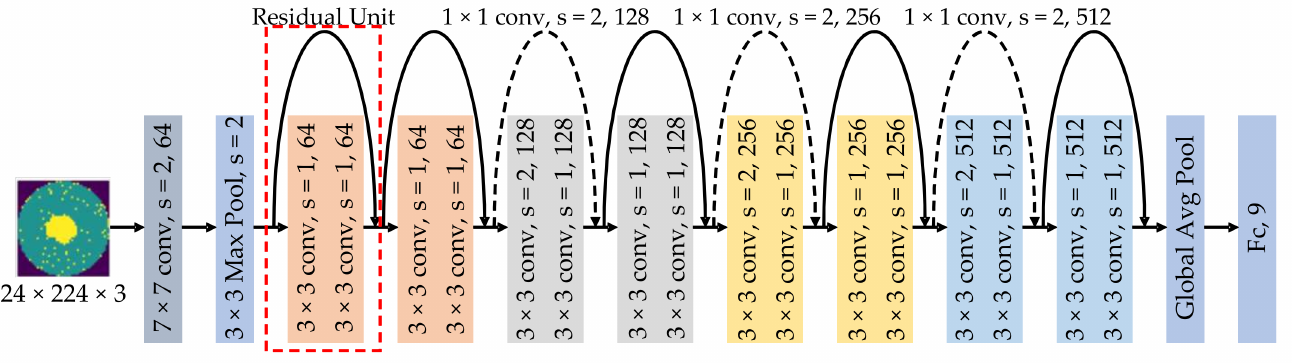
Figure 5. Structure of